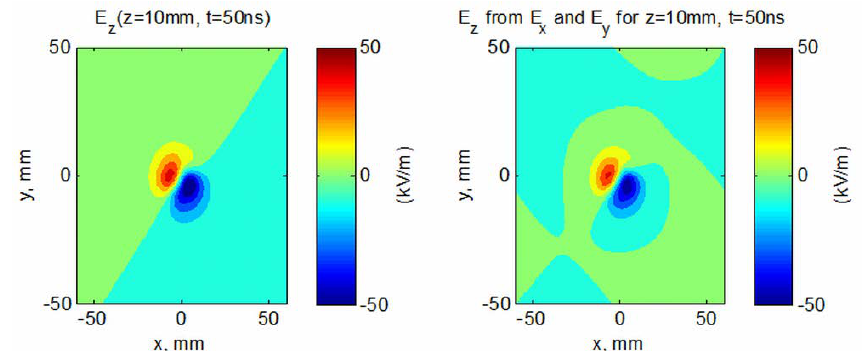
Figure 19: Comparison between the E z components directly computed and extracted at the instant time t = 50 ns across the horizontal plane at z = 10